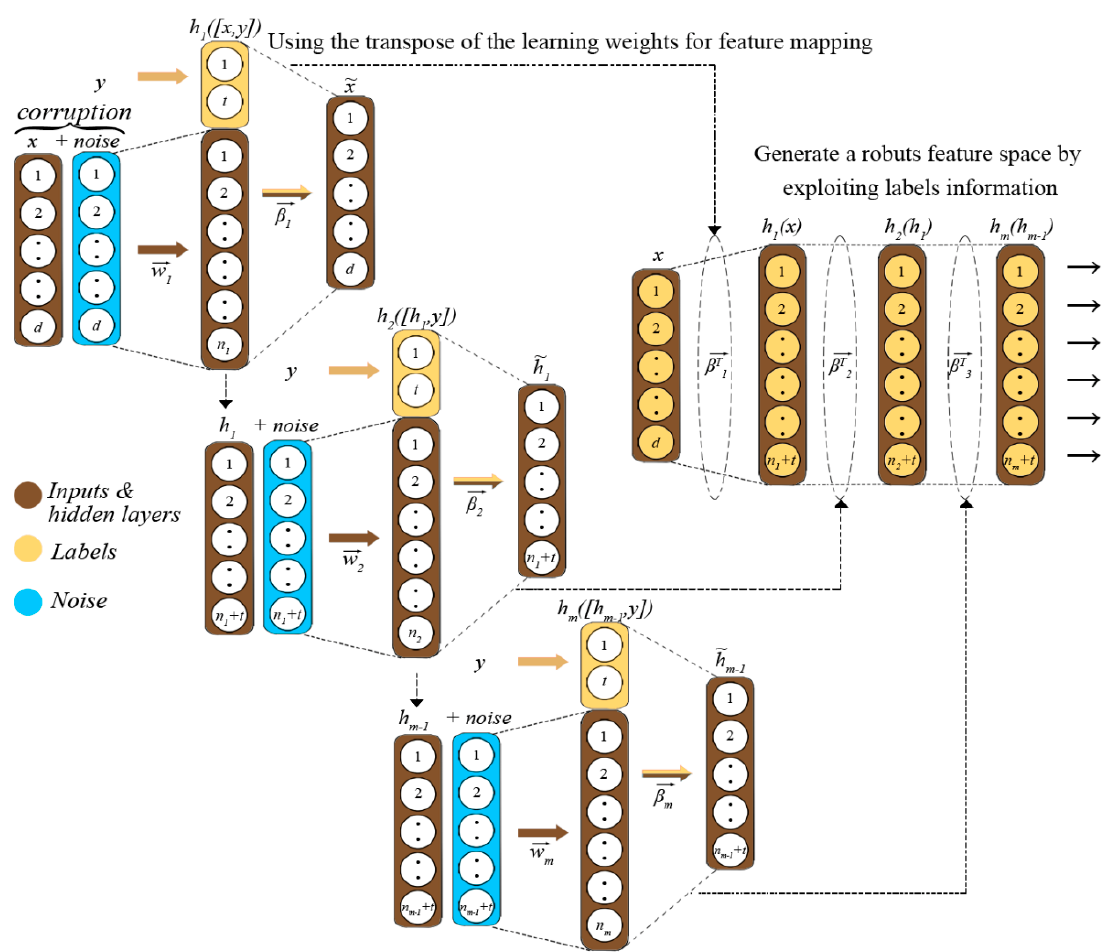
Figure 9. Process of integrating labels into a robust denoising scheme.